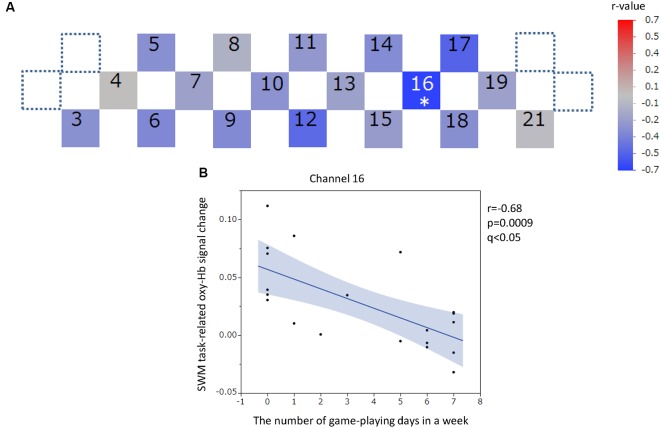
SWM task-related oxy-hemoglobin signal change and the number of gaming days in 1 week. Levels of correlation are illustrated by colored squares (A). The color spectrum bar indicates the r-value scale. The channel with statistical significance even after FDR correction is indicated by an asterisk (q < 0.05). The scatter plot with a regression line and 95% confidence interval represents the significant channel (B). SWM, Spatial working memory; oxy-Hb, oxy-hemoglobin.